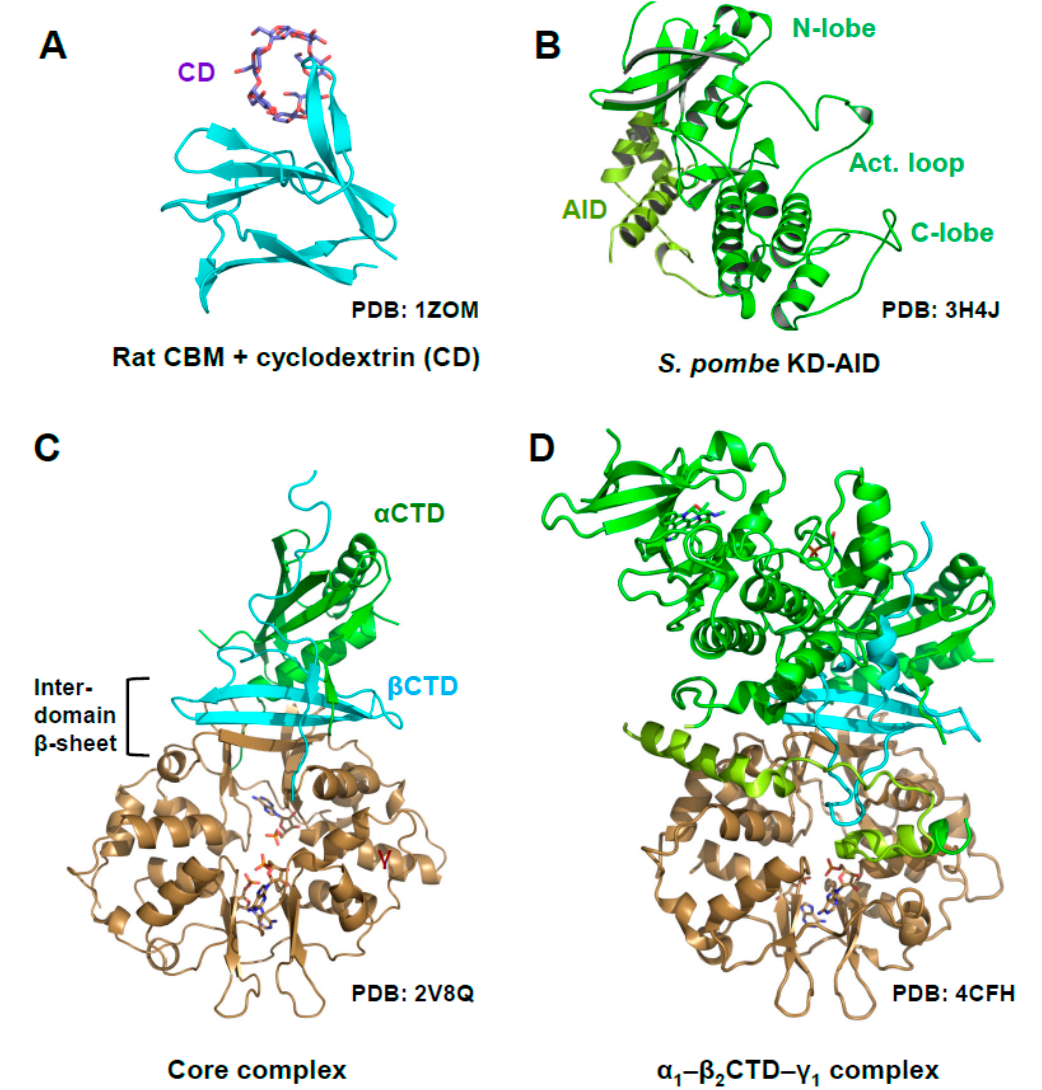
Figure 2. Structure of AMPK domains and subcomplexes. ( A ) Rat CBM bound to cyclodextrin; ( B ) Fission yeast kinase domain–autoinhibitory domain (KD-AID) complex; ( C ) AMP-bound, phosphorylated mammalian AMPK core complex (rat α 1 -human β 2 -rat γ 1 ); ( D ) AMP-bound, phosphorylated rat α 1 —human β 2 CTD—rat γ 1 complex.